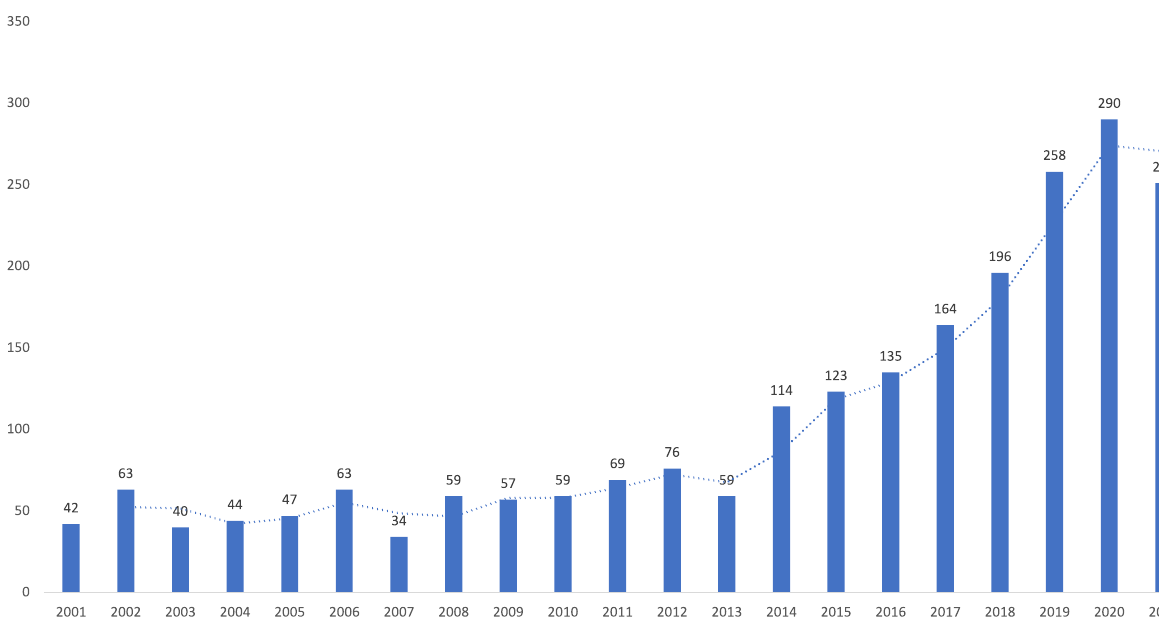
Fig. 2 Average annual publications of rice research in Indonesia and the Philippines from 2001 to 2021. The average number of annual publications on rice research in Indonesia and the Philippines from 2001 to 2013 was only 57 papers but elevated to hundreds beginning in